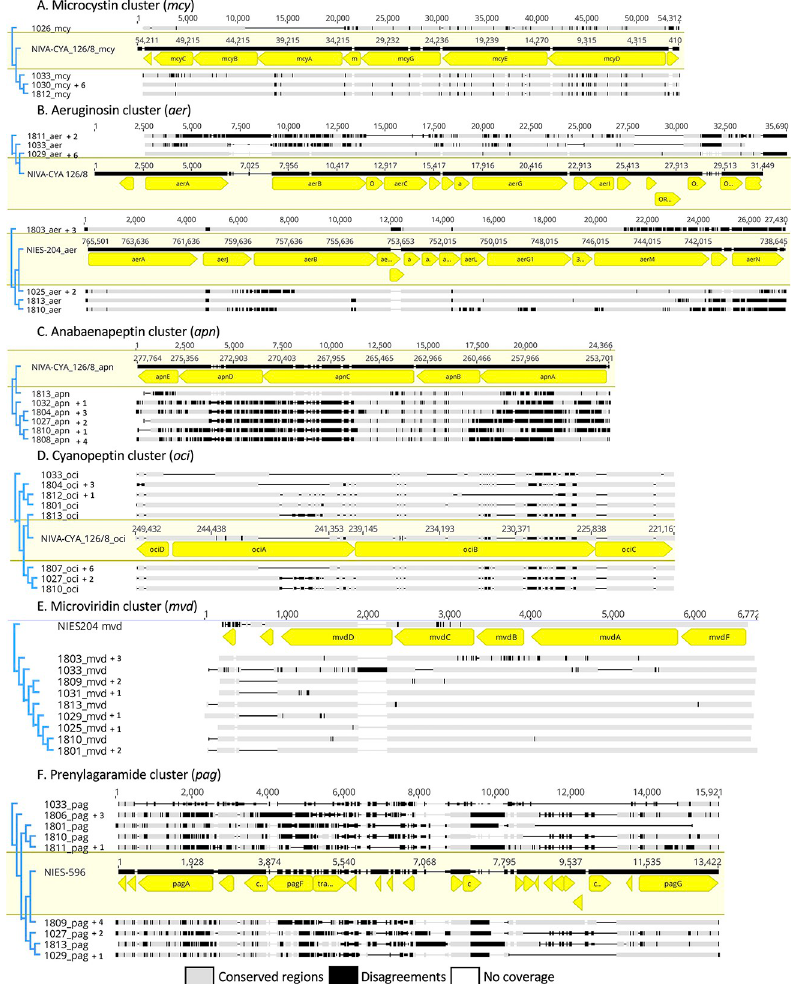
Fig 4. Alignments of unique secondary metabolite clusters as references for the relatedness of sequences between isolates. Reference sequence is highlighted in yellow and includes gene annotations for the clusters. Black segments in the non-highlighted sequences indicate points of difference, grey segments indicate similar regions, and the lines indicate regions of no coverage. A. Microcystin ( mcy ) cluster. B.Aeruginosin ( aer ) cluster. C. Anabaenapeptin ( apn ) cluster. D. Cyanopeptin ( oci ) cluster. E. Microviridin ( mvd ) cluster. F. Prenylagaramide cluster ( pag ). For which isolates were collapsed into each head sequence, see S4